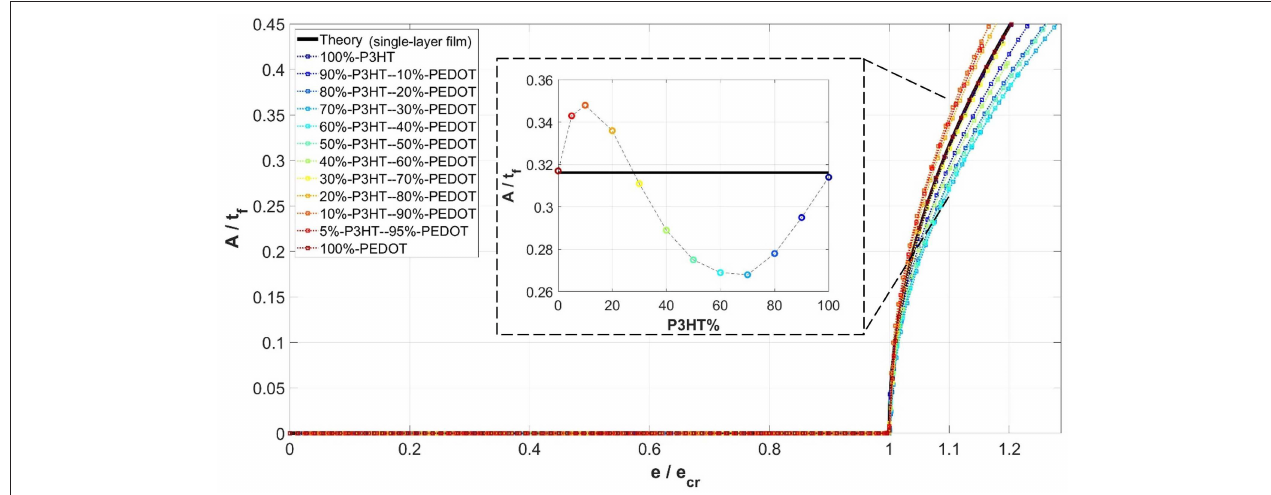
FIGURE 6 | Variations of simulated wrinkling amplitude, normalized by total thickness of the film ( A / t f ), with the progression of normalized applied compressive strain ( e e ), for different fractional volume percentages of the composite films, for the case of plane strain (PE) under direct compression. Note that the amplitudes shown in cr = the inset pertain to e e cr